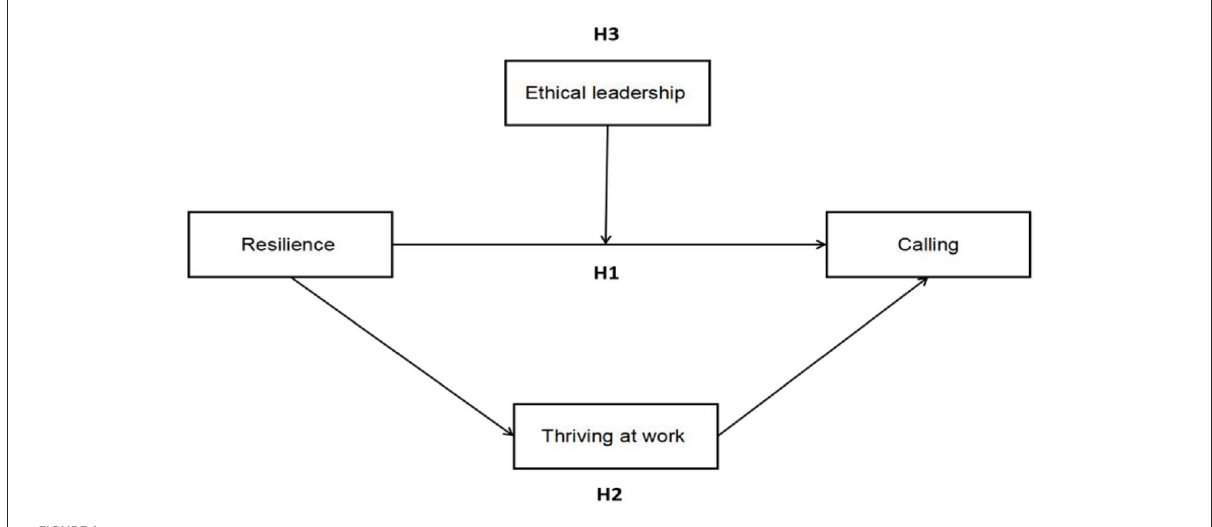
FIGURE1 Conceptual